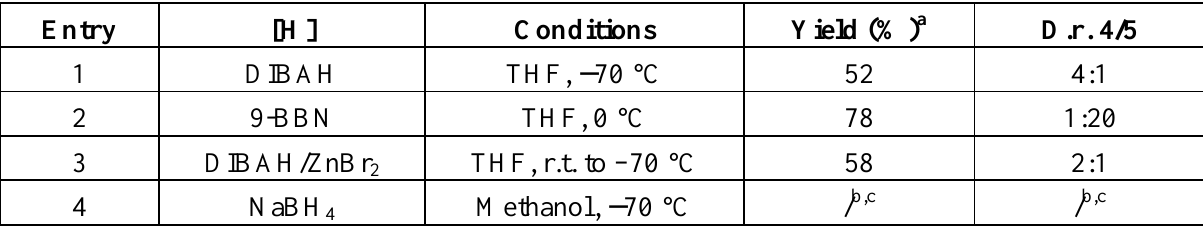
Table 1 . Reduction of sulfinimine ( S )- 3